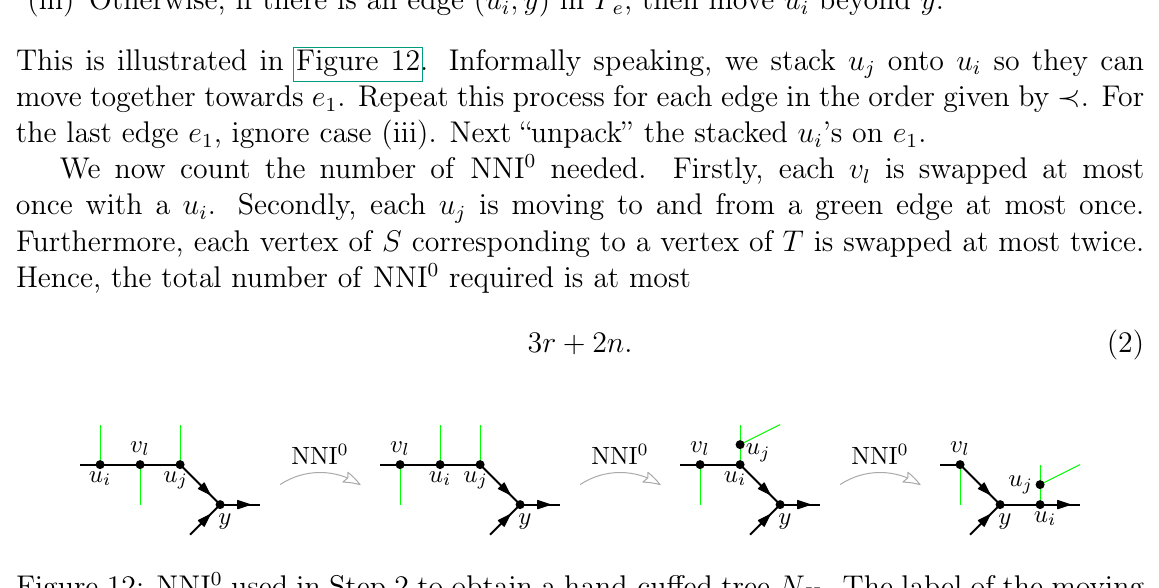
. The label of the moving H